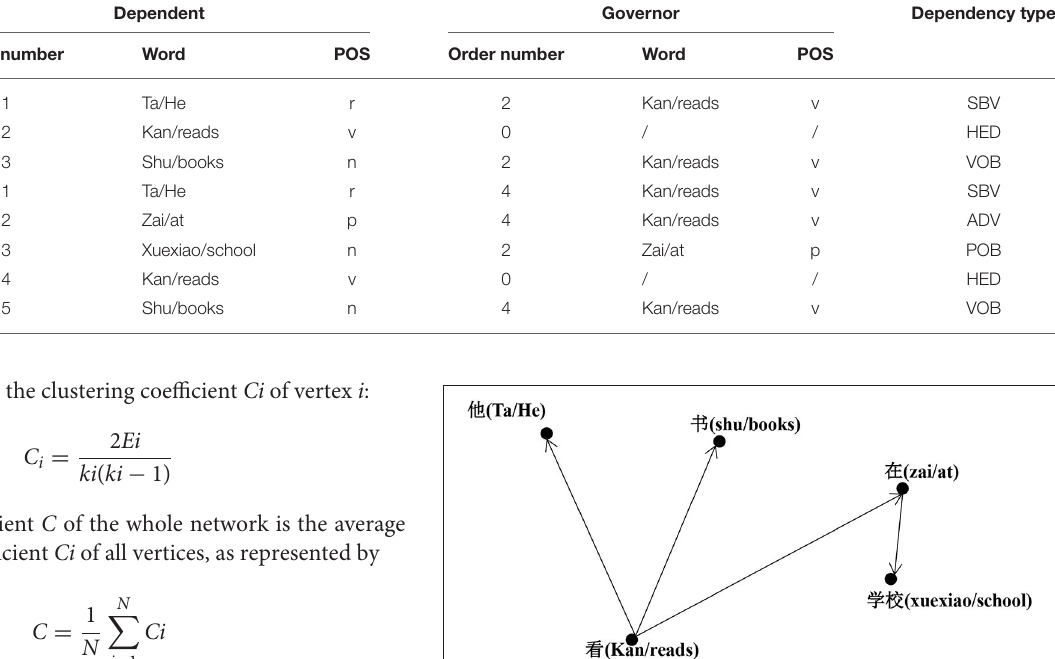
TABLE 2 | Annotation of the sample sentences in Chinese. Sentence